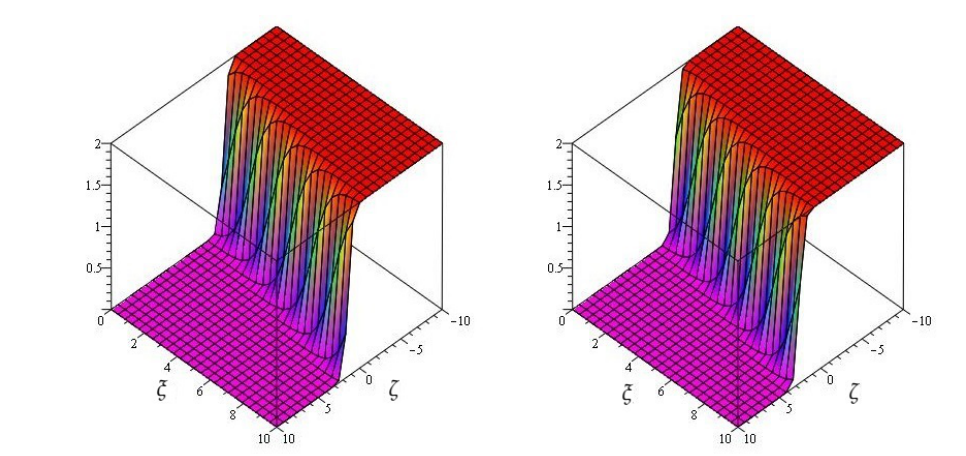
Figure 7. The exact and numerical solutions of u ( ξ , ζ , τ ) of Example 2 at α = 1.